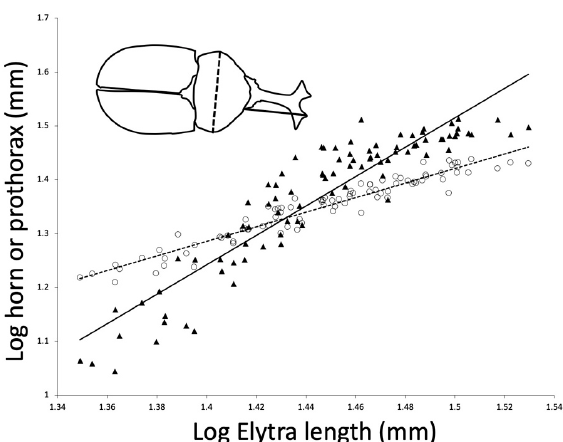
Figure 1. Relationship between horn length, prothorax width, and elytra length in Trypoxylus dichotomus males from Kyoto, Honshu, Japan. Both horn length (solid line, major axis slope = 3.15, 95% CI 2.90–3.46) and prothorax width (dashed line, major axis slope = 1.42, 95% CI 1.34–1.51) scale with positive allometry compared to elytra length, although horn length has a steeper slope than prothorax width. Insects 2019 , 10 , x When comparing the relationship between horn length and prothorax width across populations, the allometric slope did not vary (F 3, 200, = 1.52, p = 0.21; Figure 2a). However, the Kyoto and Hokkaido beetles had significantly longer horns for a given body size, compared to the Taiwan and Yakushima beetles (ANCOVA F 3, 200 = 20.7, p > 0.001; Figure 2a).